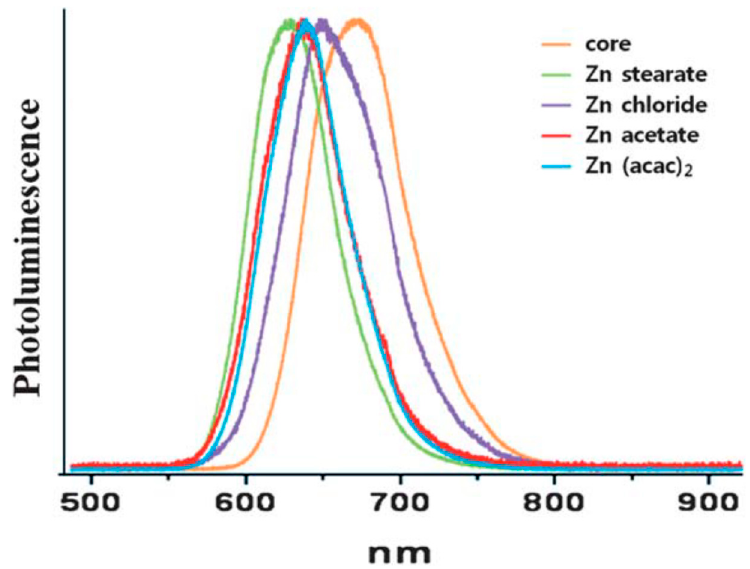
Figure 5. Blue-shifted emission spectra with different Zn precursors [70].